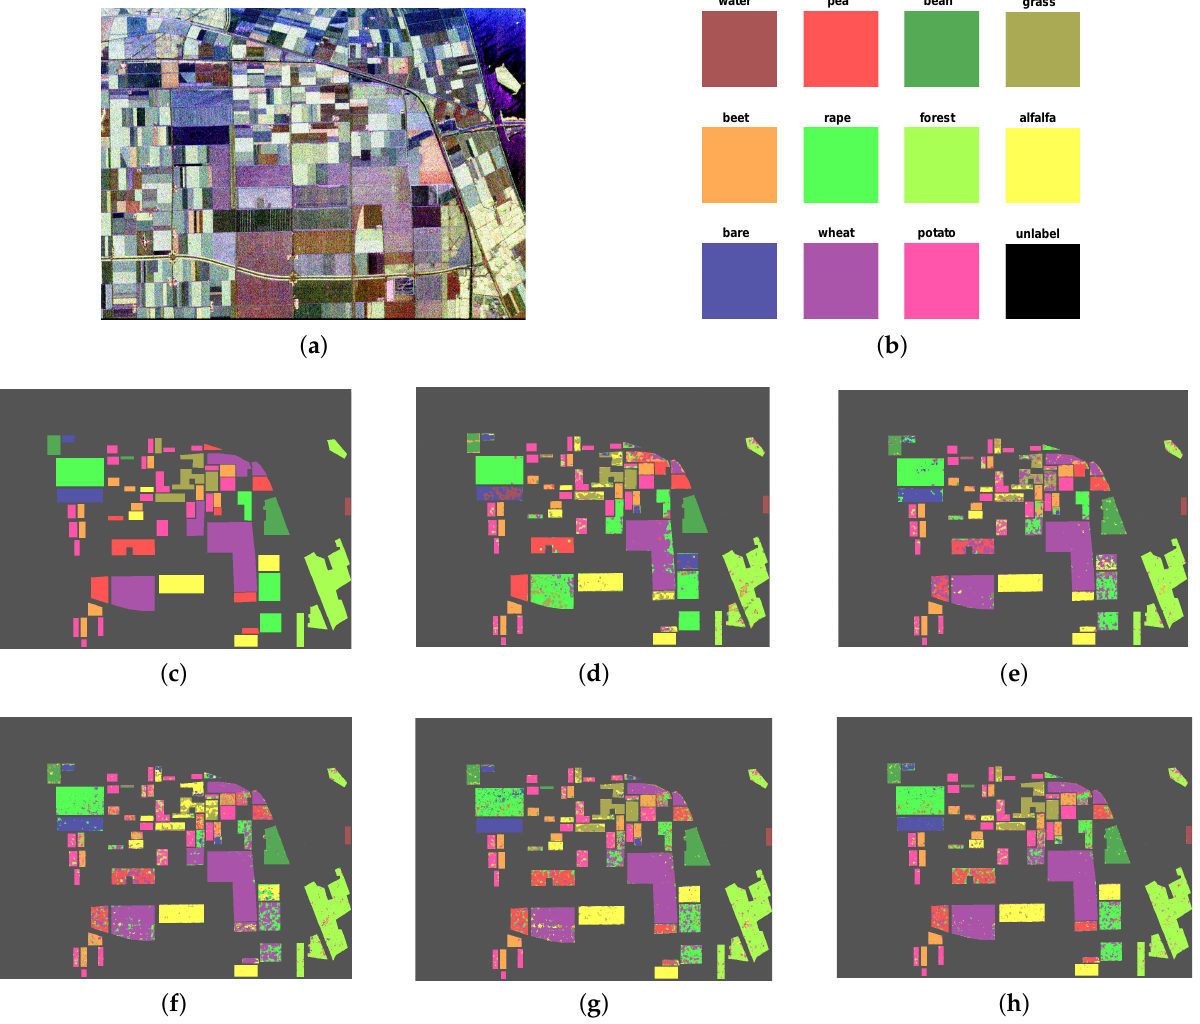
Figure 6. AIRSAR L-band PolSAR image of Flevoland-1989. ( a ) Pauli RGB composite image for the original data. ( b ) Color code. ( c ) Ground truth map. ( d ) Result of the Wishart-ML method. ( e ) Result of the LE-NDR method. ( f ) Result of the ND-KSVD method. ( g ) Result of the RSC-SVM method. ( h ) Result of our